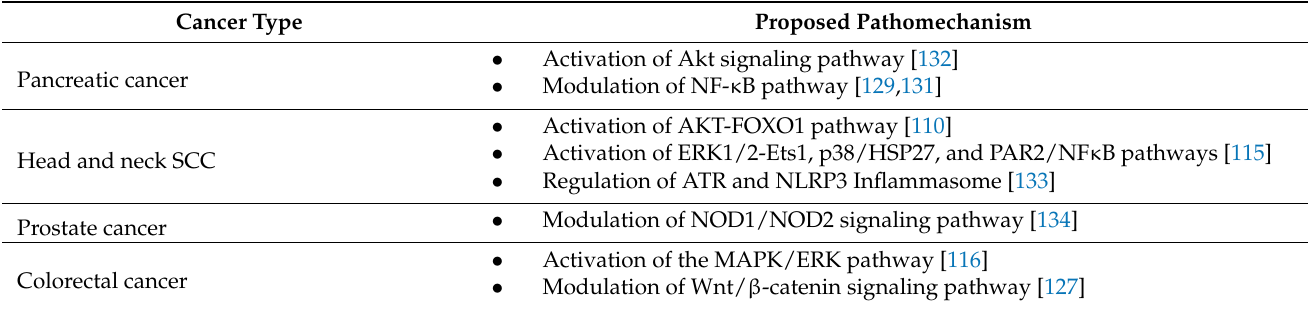
Table 1. List of different types of cancer associated with periodontal disease and the proposed